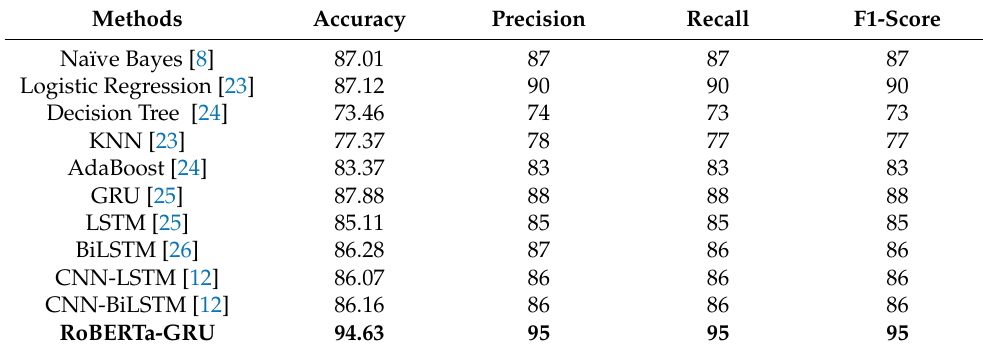
Table 7. The comparison results on the IMDb.